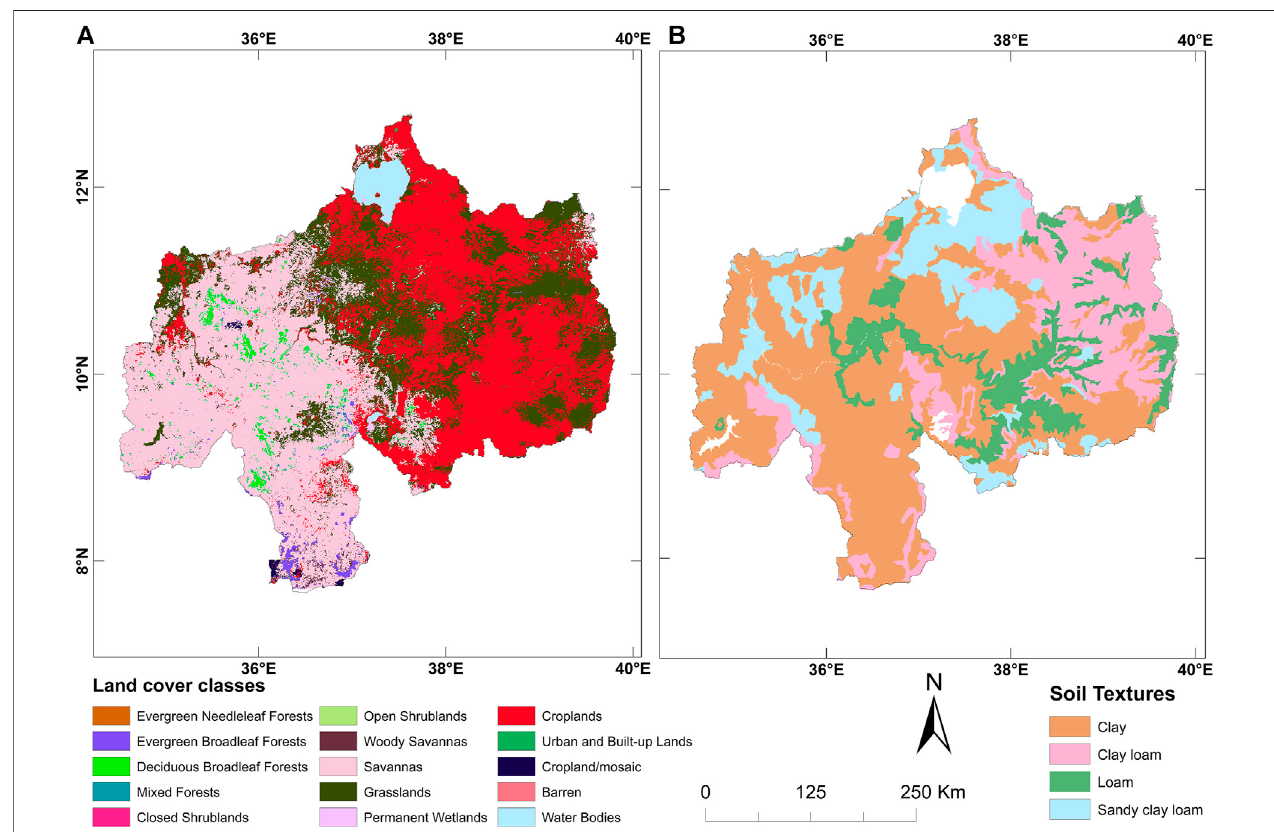
FIGURE 3 | The distributions of land cover (A) and soil textures (B) in the UBNRB.